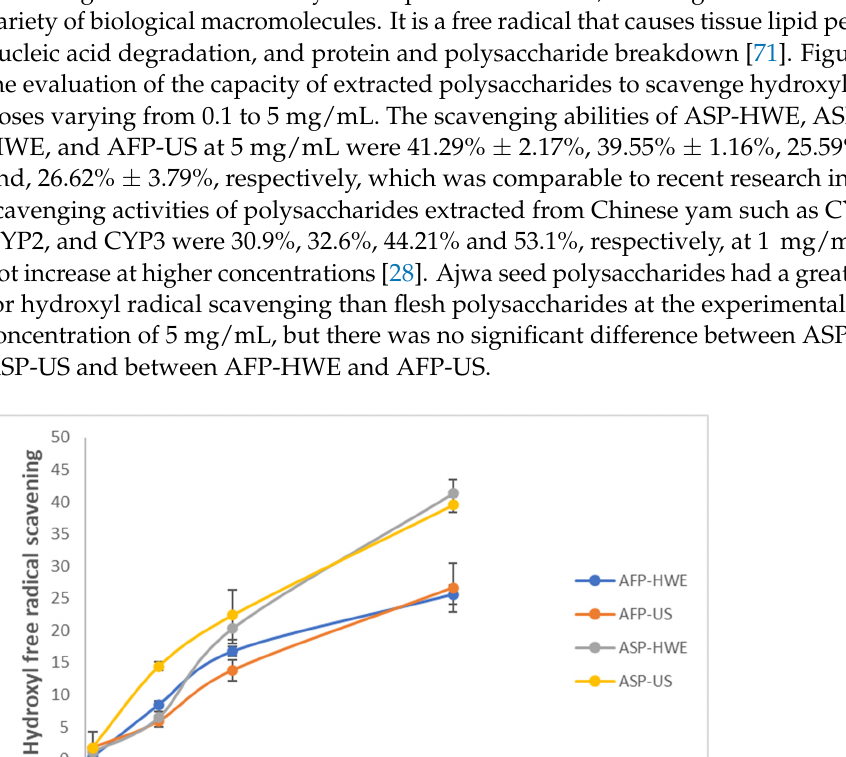
Figure 5. The Fe 2+ chelating ability of polysaccharides extracted from Ajwa seed and flesh. Results are presented as means ± standard deviations ( n = 3). Differences are statistically significant if p < 0.05 when compared to the control.